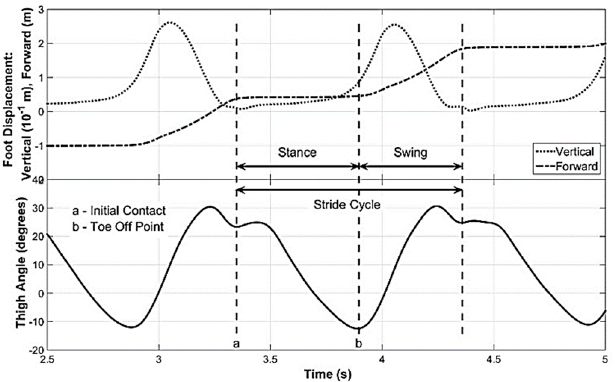
Figure 2. Thigh angle synchronized with the vertical and forward movements of the foot. Vertical and forward movements of the foot is used to identify the key points of the thigh angle waveform.